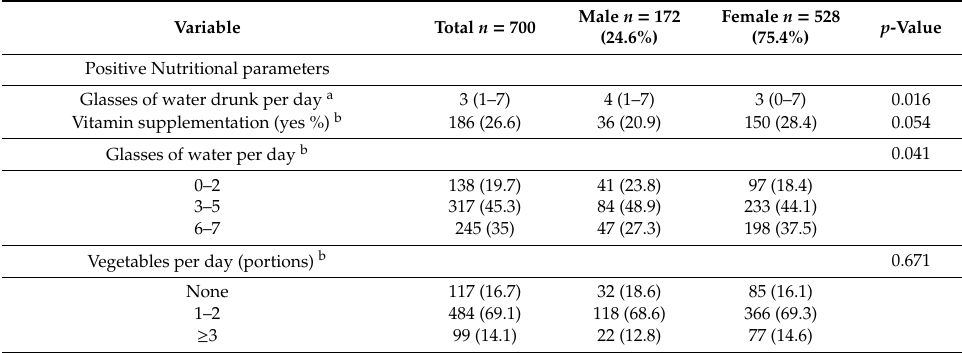
Table 3. Frequency of nutritional consumption in the study